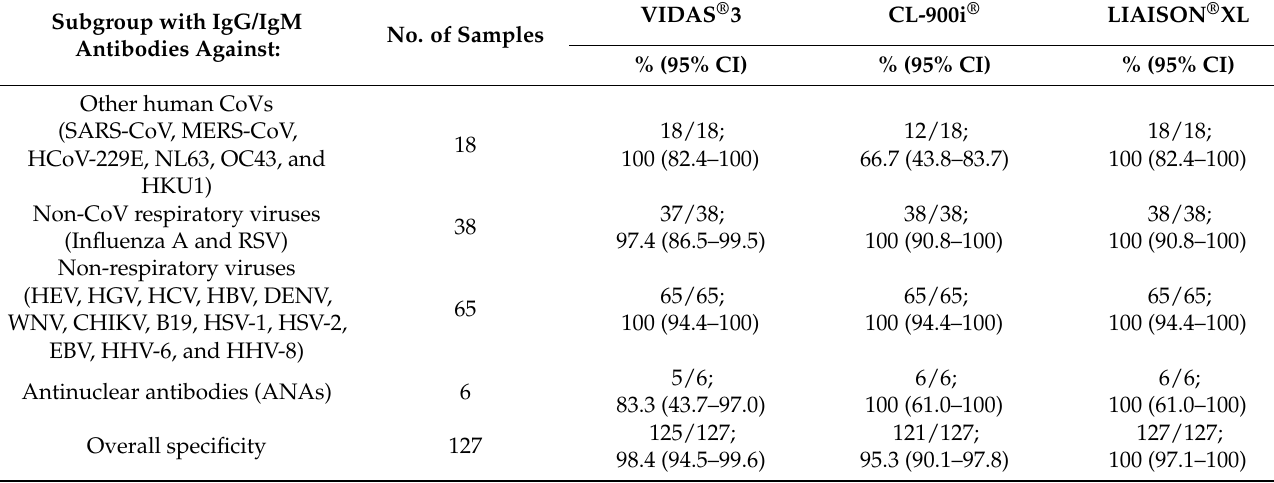
Table 3. The specificity of each automated analyzer according to the negative control subgroups ( n = 127). Subgroup with IgG/IgM Antibodies